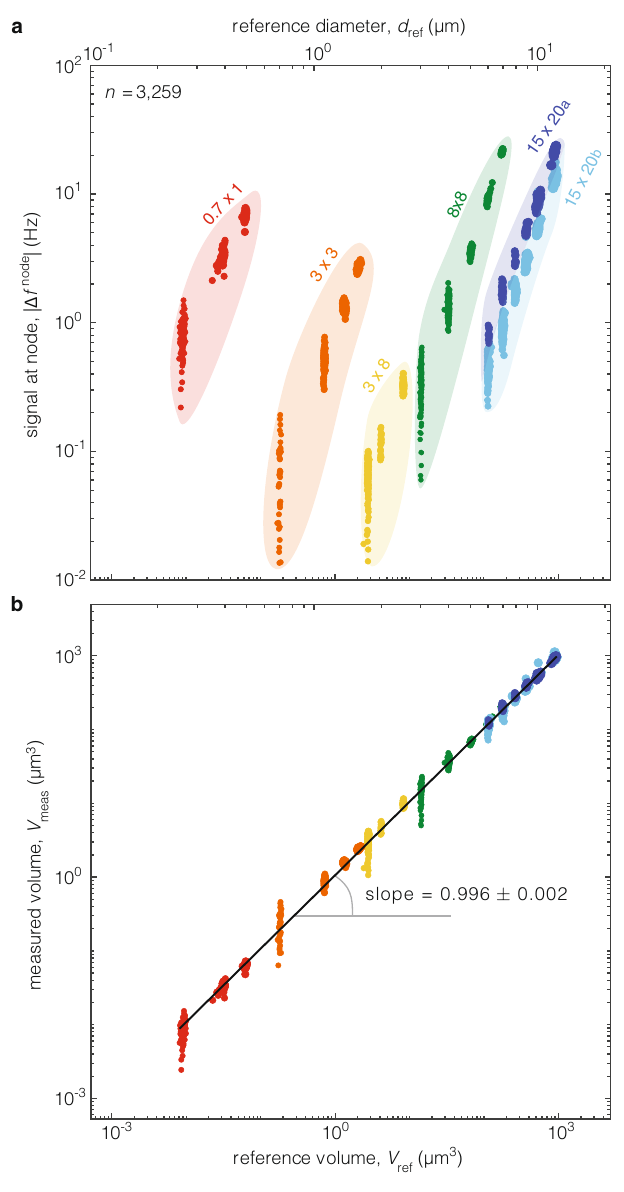
Fig. 4 Experimental validation of theory. a Measurements of the frequency change signal Δ f node at the node position (Fig. 3b) for polystyrene particles suspended in water in six different devices. The reference size, (radius, a ref , and volume, V ref ) is measured from the antinode signal. Note that in the present experiments, Δ f node < 0. The colored islands represent each different device with symbols referring to Fig. 2; n is the total number of measurements across all experiments. b Measured volume, V meas , vs reference particle size as in ( a ). V meas is calculated from the node signal, Δ f node , using Eq. (1) (Supplementary Fig. 6). A linear regression of V meas vs V ref is performed where the bounds give a 99.9% con fi dence